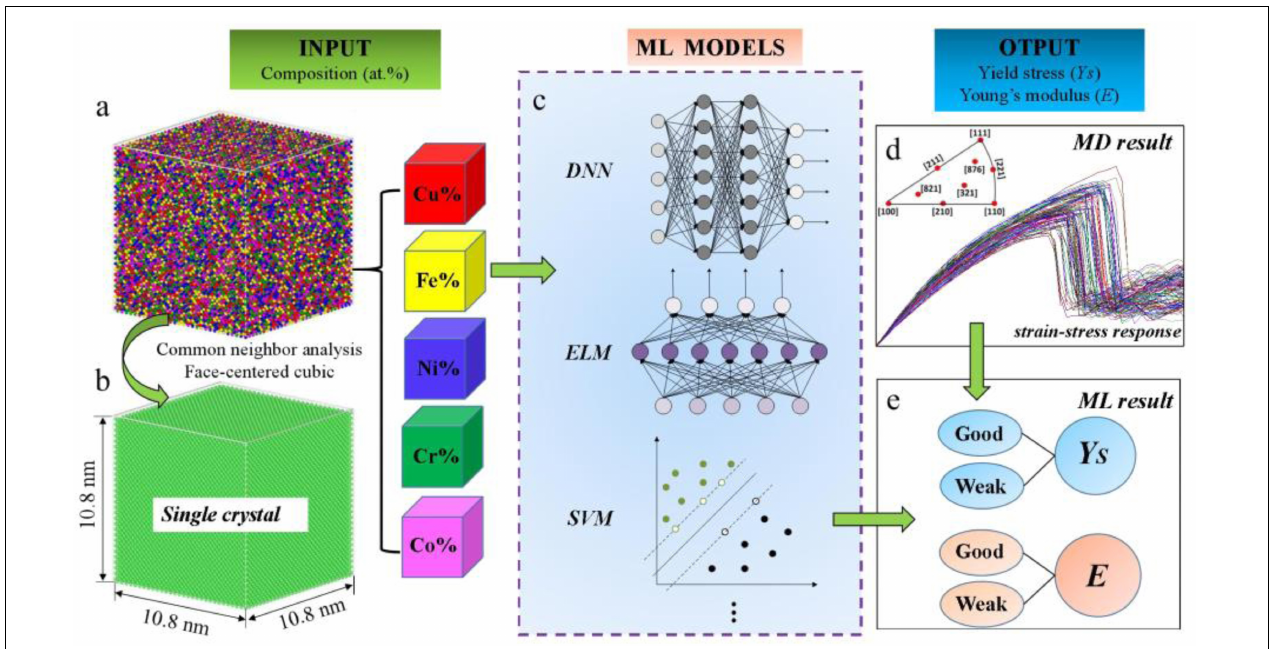
FIGURE 7 | Schematic diagram of molecular dynamics simulation and machine learning methods (Islam et al., 2018). (a) Simulated CuFeNiCrCo single-crystal sample. (b) The CuFeNiCrCo single-crystal sample analyzed by neighbor analysis (CNA) method. (c) Schematic of some machine learning models. (d) Strain-stress curses of single-crystal CuFeNiCrCo samples. (e) Prediction of the mechanical properties by machine learning